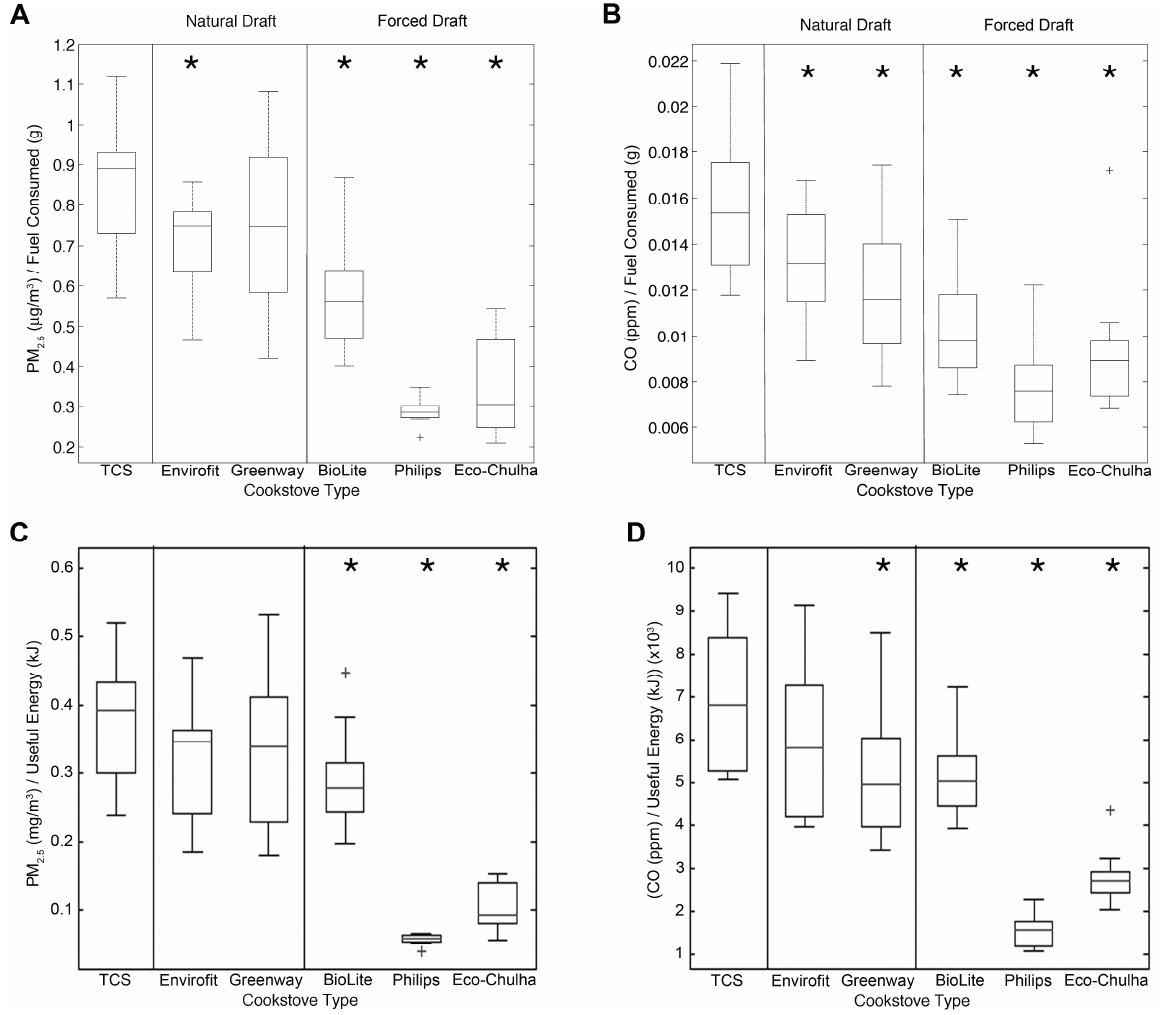
Figure 3. Pollutant concentrations after normalization for fuel consumption or useful energy. ( A ) PM 2.5 concentrations were significantly reduced for the BioLite, Envirofit, Phillips, and Eco-Chulha stoves ( p < 0.001) after normalization for fuel consumption. Normalized PM 2.5 concentration reduction for the Greenway stove was marginally significant ( p = 0.056). ( B ) CO concentrations were significantly reduced for all ACSs after normalization for fuel consumption * p < 0.03. ( C ) PM 2.5 concentrations were significantly reduced for the BioLite, Phillips, and Eco-Chulha stoves after normalization for useful heat energy. ( D ) CO concentrations were significantly reduced for Greenway, BioLite, Philips, and Eco-Chulha ACSs after normalization for useful energy